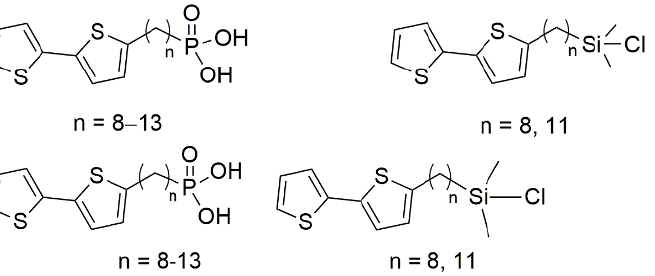
Figure 2. Chemical structures of designed derivatives with phosphono and chlorodimethylsilyl anchoring groups.